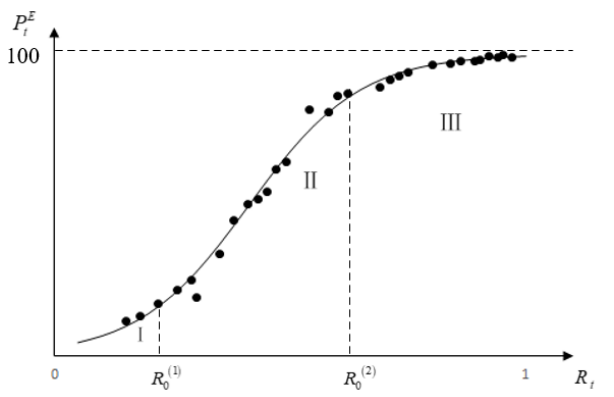
P . Figure 3. Sum scatter plot and fitting curve of the 30 cases of R t and P E t R and E t t